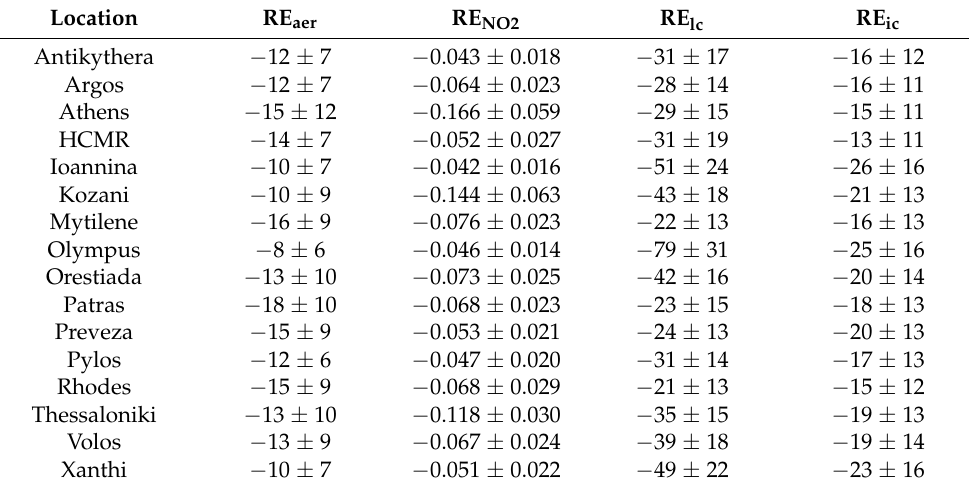
Table 2. Annual average radiative effect of aerosols (RE aer ), tropospheric NO 2 (RE NO2 ), liquid clouds (RE lc ) and ice clouds (RE ic ) (in W/m 2 ) for the period 2005–2019 with the corresponding ± 1 σ